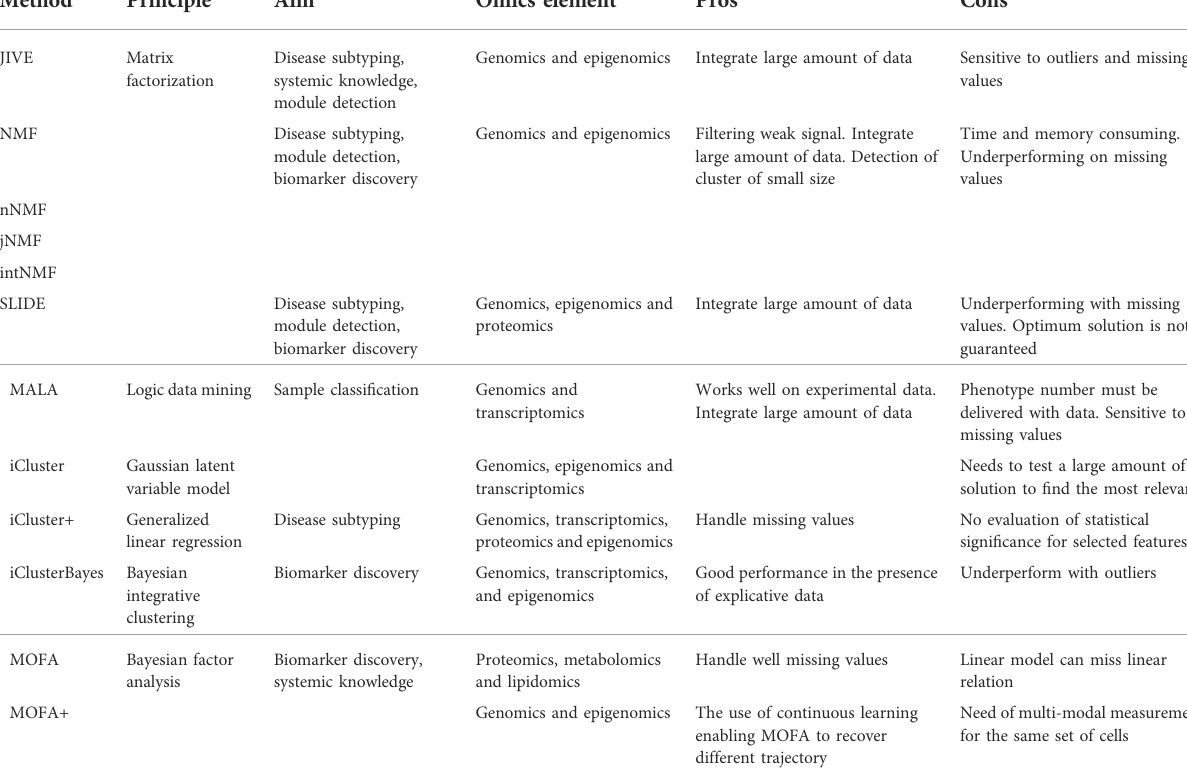
JIVE : joint and individual variation explained. (n, j, int) NMF : (network, joint, integrative) non-negative matrix factorization.